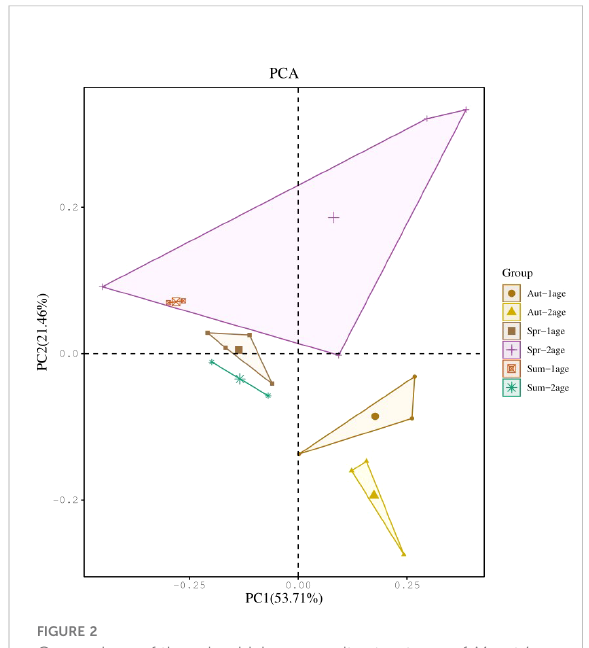
FIGURE 2 Comparison of the microbial community structures of Meretrix meretrix samples of the same age. Principal Coordinate Analysis (PCoA) of the 16S rRNA gene sequences using Bray-Curtis difference grouped by